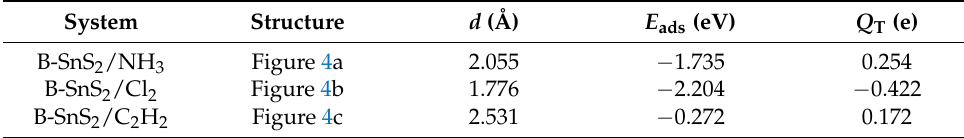
Figure 4. Gas adsorption on B-SnS 2 . ( a ) B-SnS 2 /NH 3 , ( b ) B-SnS 2 /Cl 2 , ( c ) B-SnS 2 /C 2 H 2 . The distance is Å. Table 2. Adsorption parameters of gas molecules on B-SnS 2 . Table 2. Adsorption parameters of gas molecules on B-SnS 2 .